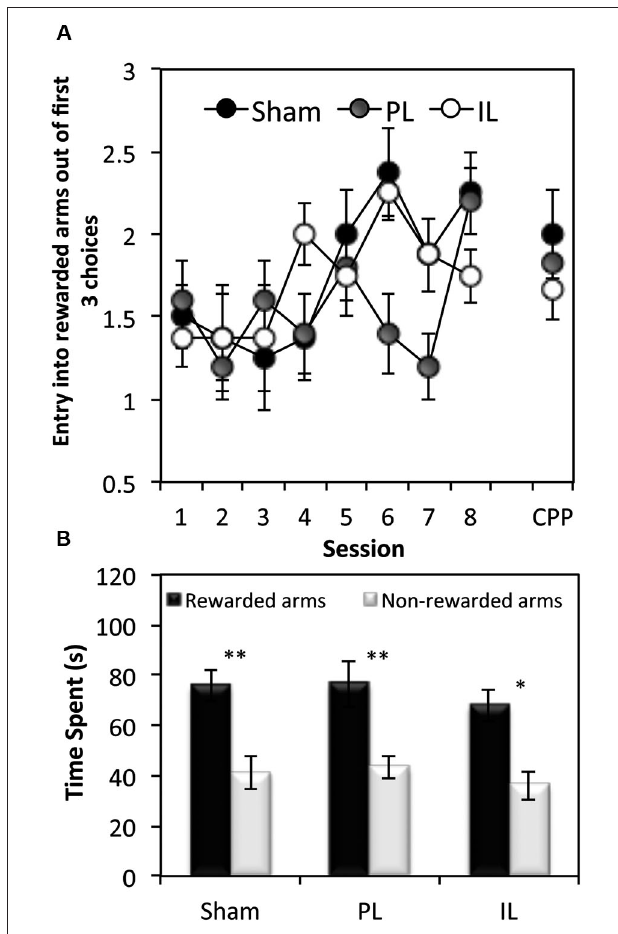
FIGURE 5 | Tests of spatial learning. (A) Spatial reference memory test—the mean ± SEM number of arm entries out of the first 3 entries that were made into rewarded arms at the beginning of each session (and the conditioned place preference (CPP) test session), before the presentation of the CS. (B) Conditioned place preference test, expressed as mean ± SEM total time spent in the 3 rewarded or 3 non-rewarded arms (within a 5 min session) for sham controls, IL and PL-lesioned groups. * p < 0.05, ** p < 0.01 difference between time spent in rewarded vs. non-rewarded